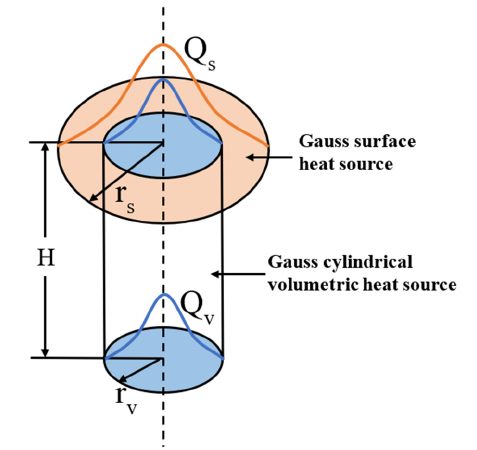
Figure 2. Schematic diagram of coupled heat source.